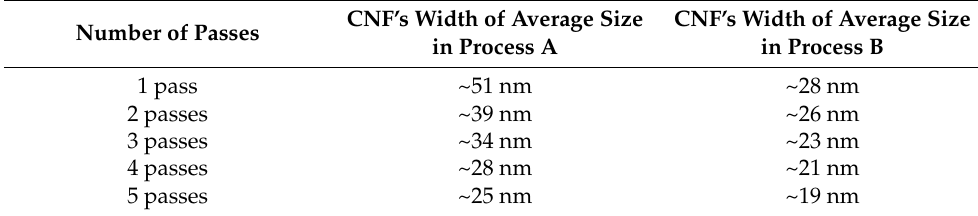
Table 3. Comparison of the CNF’s width with average size.